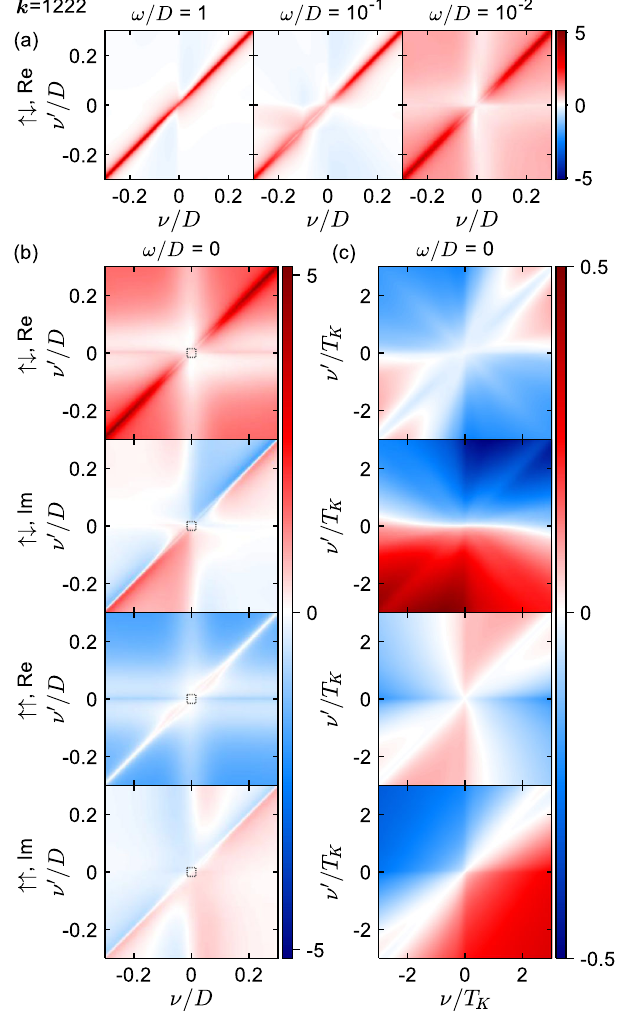
1 (cid:3) FIG. 13. KF 4p vertex F ½ in the strongly interacting AIM, σσ 0 1 (cid:3) − F ½ 1 (cid:3) U= Δ ¼ 5 , U=D ¼ 1 = 5 , T ¼ 10 − 4 D . (a) Re ð F ½ ↑↓ 0; ↑↓ Þ =U for three choices of ω > T . Lowering ω , more features build up. K 1 (cid:3) − F ½ 1 (cid:3) =U at ω ¼ 0 . (c) Enlarge- (b) All components of ð F ½ σσ 0 0; σσ 0 Þ [dashed squares in (b)], ment on the window j ν j ; j ν 0 j ≲ T K 1 (cid:3) − ˜ U 2 Z 2 Þ(cid:3) =U . The values in (c) are an order showing ½ F ½ σσ 0 = ð σσ 0 of magnitude smaller than in (b) and vanish for ν ð0Þ → 0 , showing that the low-energy retarded vertex reproduces RPT.